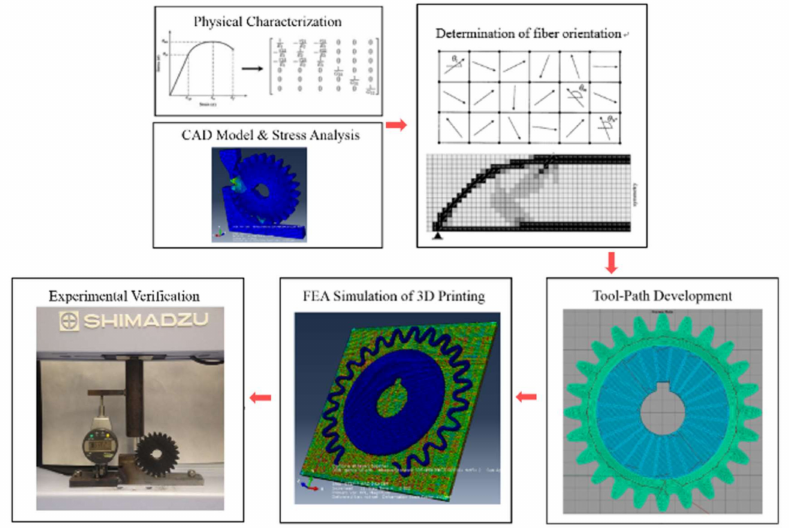
Figure 1. The workflow of the design